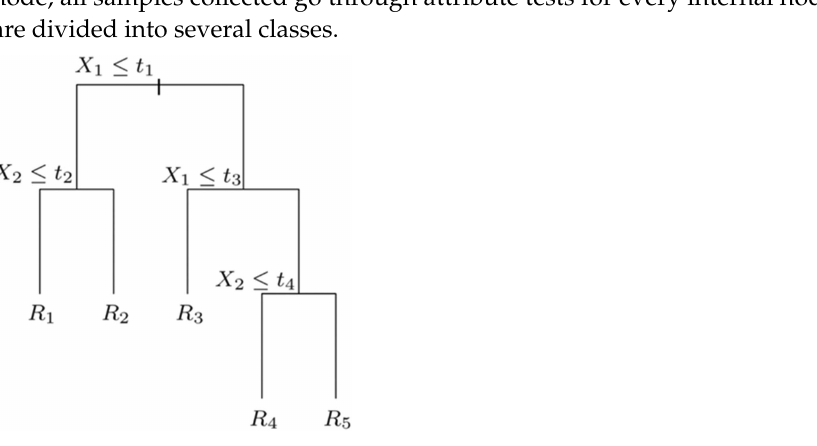
Figure 5. Construction of a decision